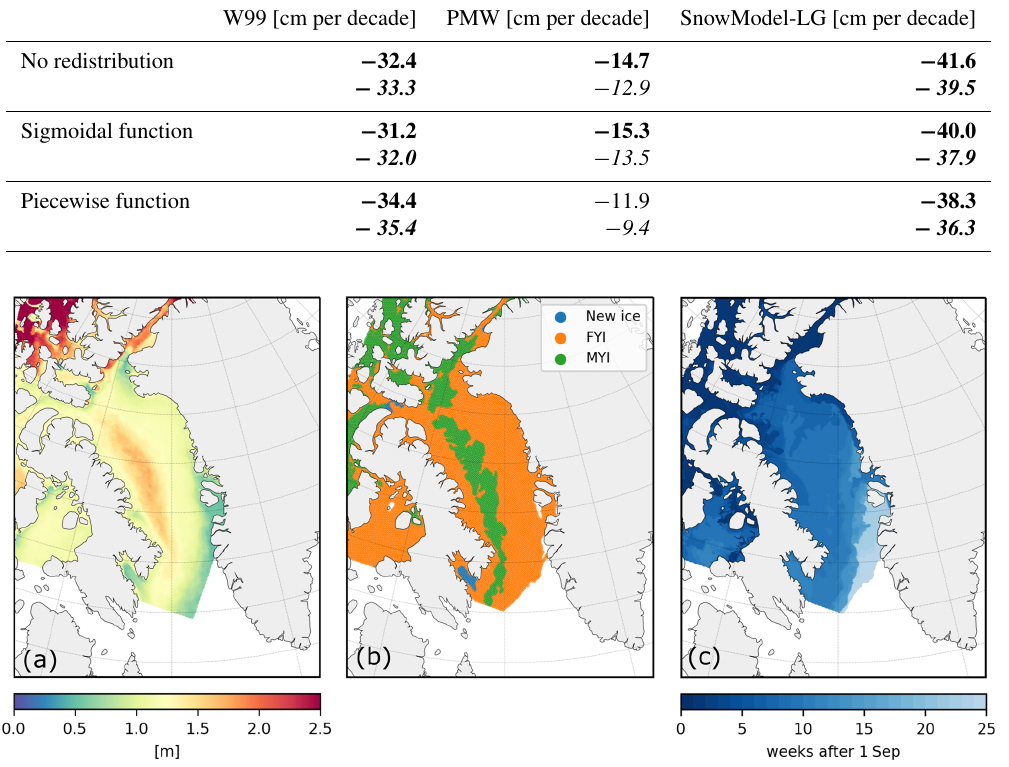
Figure 9. CIS ice chart (a) mean estimated thickness (1996–2020), (b) oldest stage of development 18 March 2019, and (c) freeze-up start date